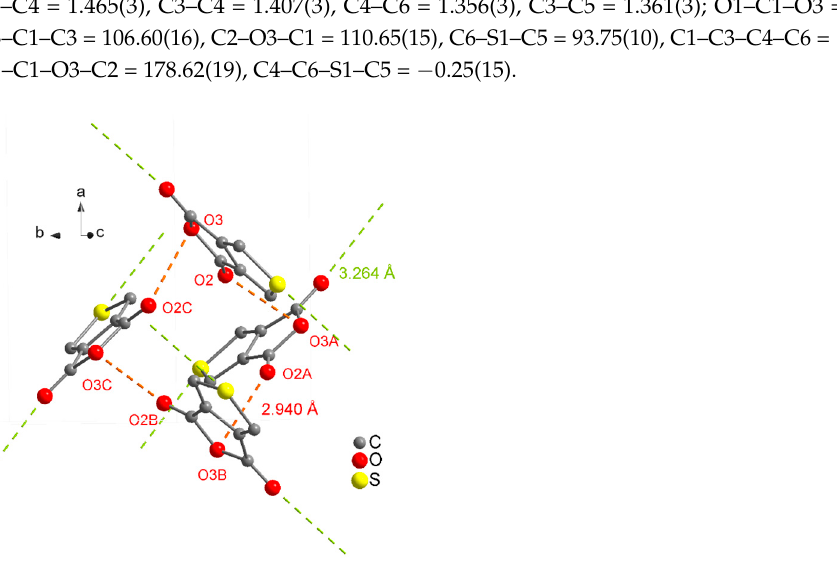
Figure 3. ORTEP (50% probability level) of the molecular structure of 4 with the atom-numbering scheme. Selected bond distances (Å), angles ( o ) and torsion angles ( o ): S1–C5 = 1.722(2), S1–C6 =